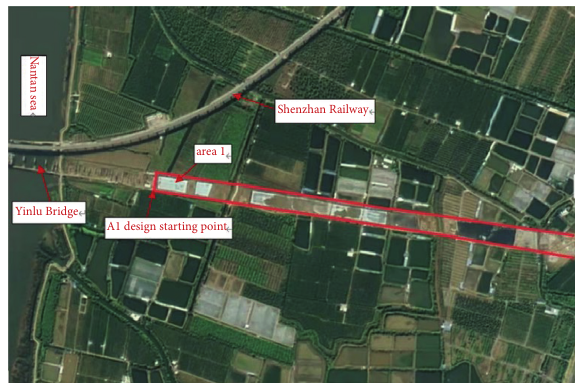
Figure 1: Aerial view of engineering